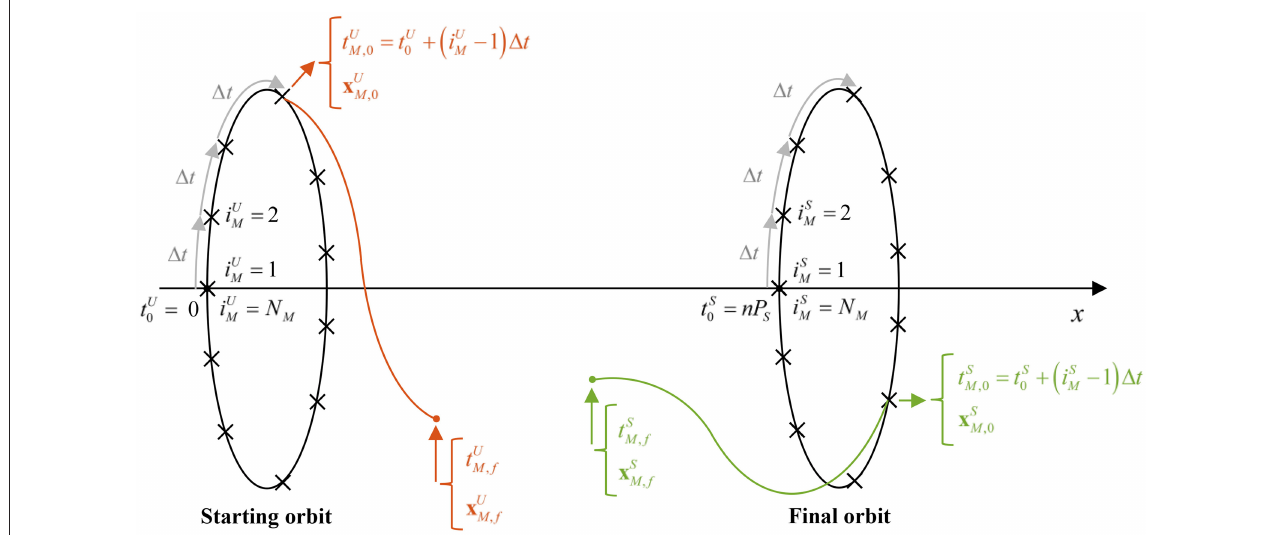
FIGURE 4 | Schematic of conventions. Note that, for a homoclinic connection the starting and final orbits are the same orbit.